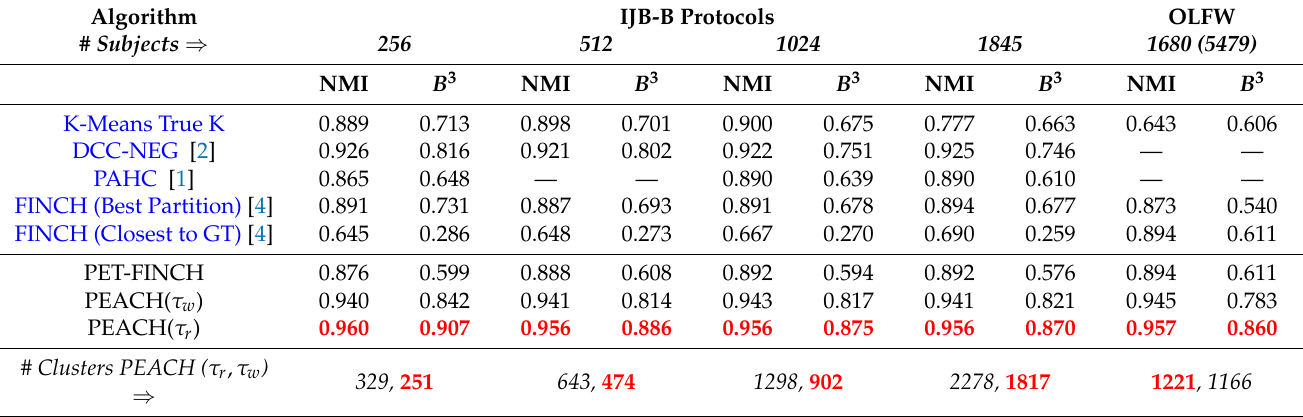
Table 1. Clustering Out-of-Distribution/Out-of-Domain data. This table shows NMI and B 3 F-scores for various clustering algorithms on the IJB-B and LFW face datasets. For IJB-B experiments, everything other than DCC-NEG uses older features from [1]; DCC-NEG uses its own (better) features and clustering from the same research group. For OLFW, we use a ResNet-101 network trained on ILSVRC 2012. We mark the best results , as well as algorithms that optimize parameters on the test